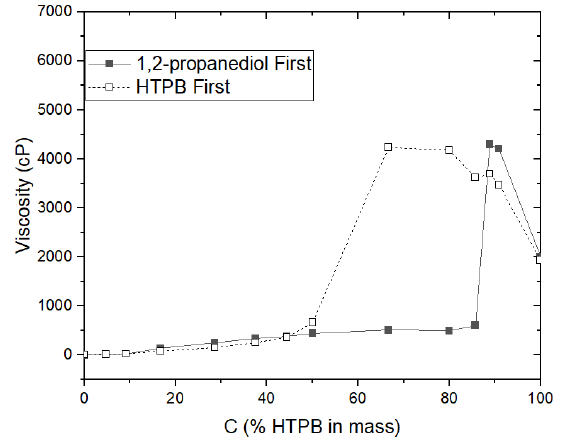
Figure 2. Viscosity profile of 1,2-propanediol and HTPB resin solutions, depending on the resin concentration, for both order of